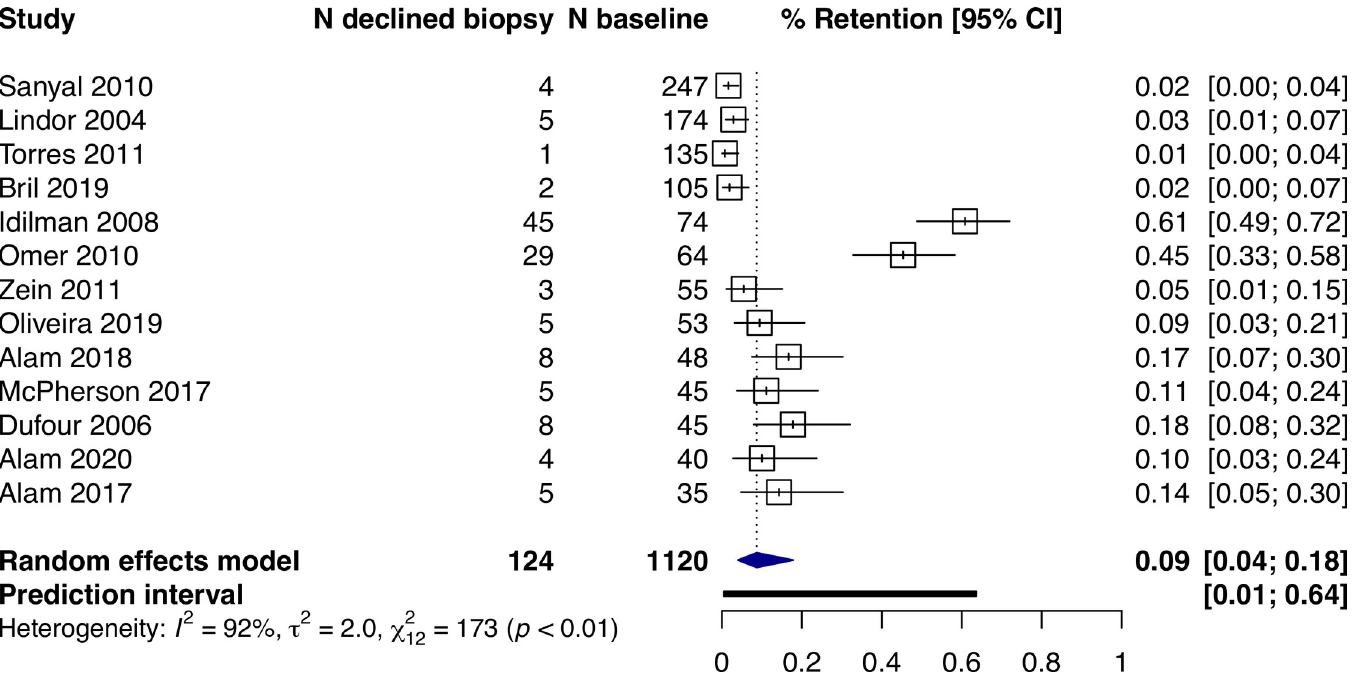
Fig 3. Proportions of participants (95% CI) reporting to specifically decline a follow-up biopsy.